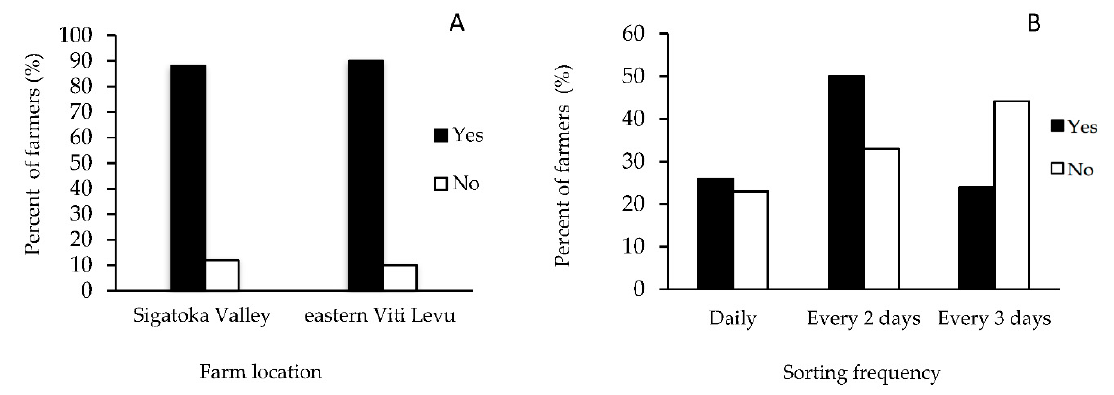
Figure 3. The percentage of Fijian tomato farmers (value chains) in the Sigatoka Valley and Eastern Viti Levu, that employed specific on-farm sorting and grading practice. ( A ) Farmers that sorted (i.e., removed poor quality or damage product) before on-farm ripening / storage verses farmers that did not pre-sort prior to ripening / storage. ( B ) The frequency of stored product sorting during the on-farm ripening period.